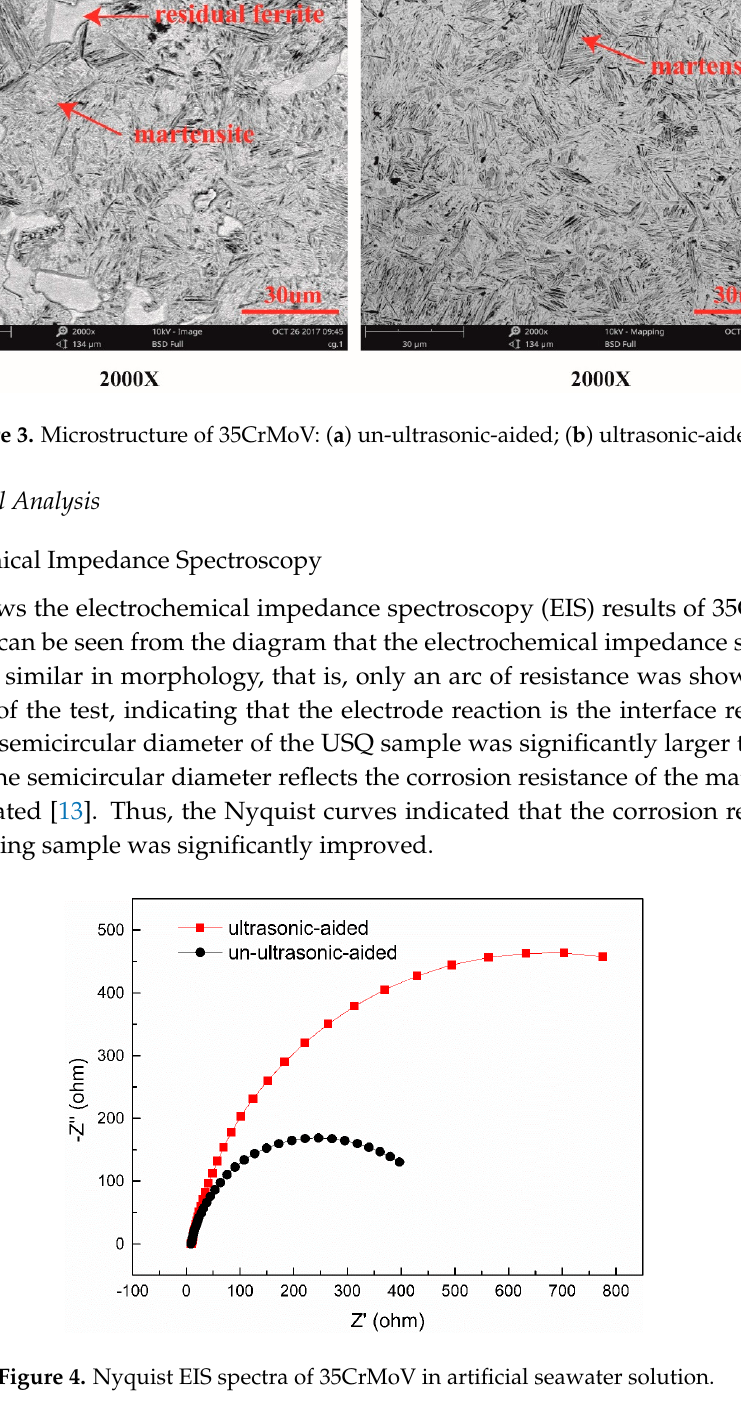
Figure 5. Equivalent circuit model used to fit the EIS data.